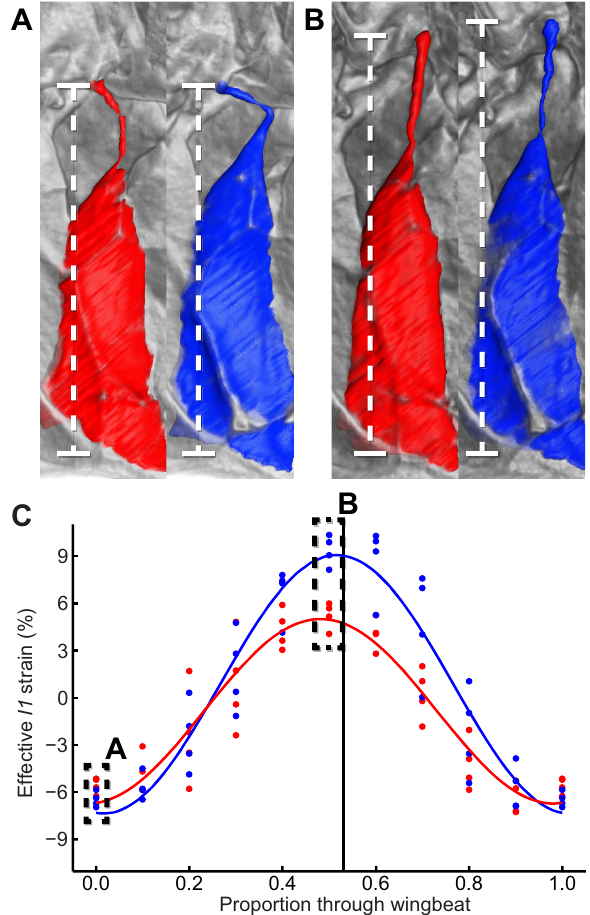
Figure 9. Buckling of the I1 tendon. (A, B) Visualizations of the I1 muscle at the start and end of the downstroke, respectively. The tendon is buckled on both wings at the start of the downstroke (A) but has been pulled straight by the end of the downstroke (B). Each panel compares the state of I1 on the high-amplitude (blue) and low- amplitude (red) wing. (C) effective strain measured along the straight line joining the attachment points of I1 (dashed line). Comparing the amplitude of this effective strain with the amplitude of the actual I1 muscle strain in Figure 6F shows that the buckling tendon accommo- dates a 4-fold enhancement in the range of movement of the first axillary sclerite on the high-amplitude wing.